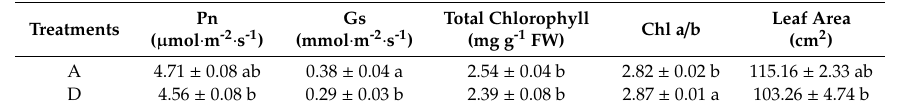
Table 1. Comparison of Pn, Gs, total chlorophyll content, Chl a/b, and leaf area in different light regimes. ( n = 10 for Pn, Gs, and leaf area. n = 7 for total chlorophyll and Chl a/b.) Treatments